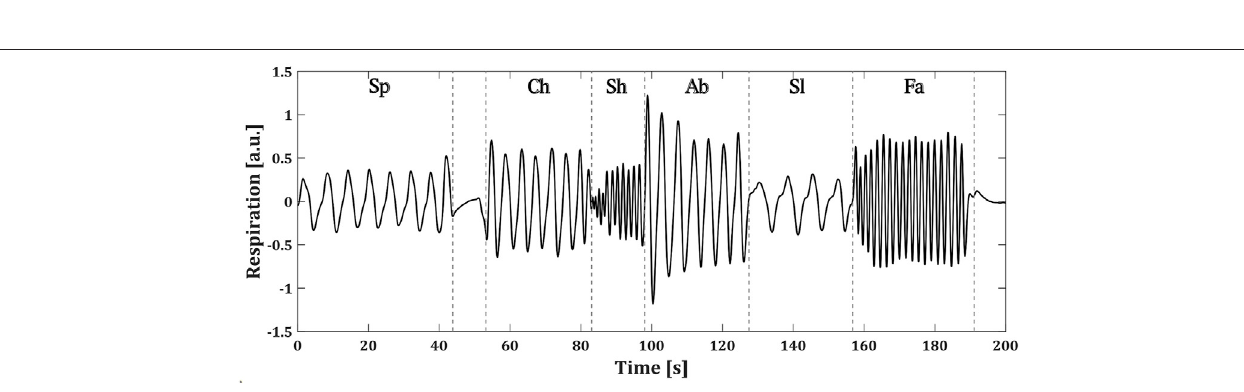
Frontiers in Bioengineering and Biotechnology |